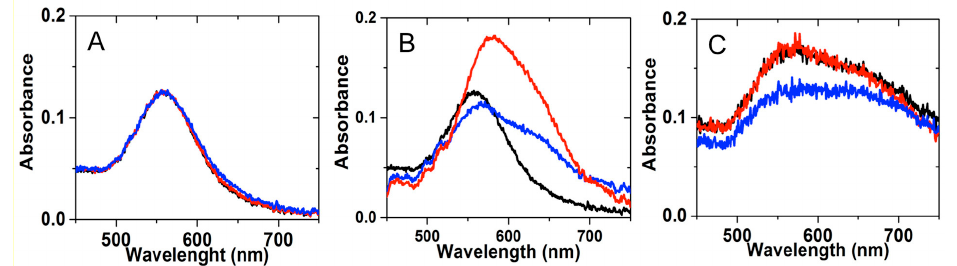
Figure 5. The extinction spectra of ( A ) Au nanoparticle substrate (sample 2); ( B ) dried BPE molecules and ( C ) dried Cyt-b5 molecules onto annealed Au nanostructures using 2 µL drop solution. Red, blue and black lines present spectra collected from three different zones on each sample.